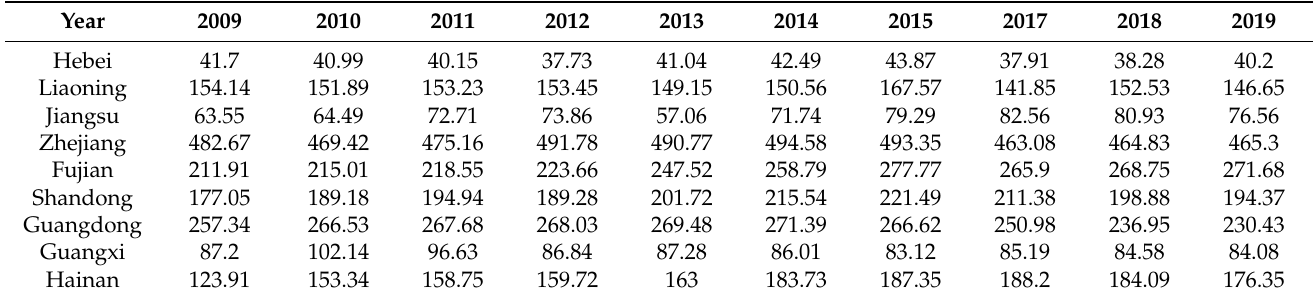
Table 7. Net carbon emissions of marine fisheries in nine coastal provinces from 2009 to 2019 (10,000